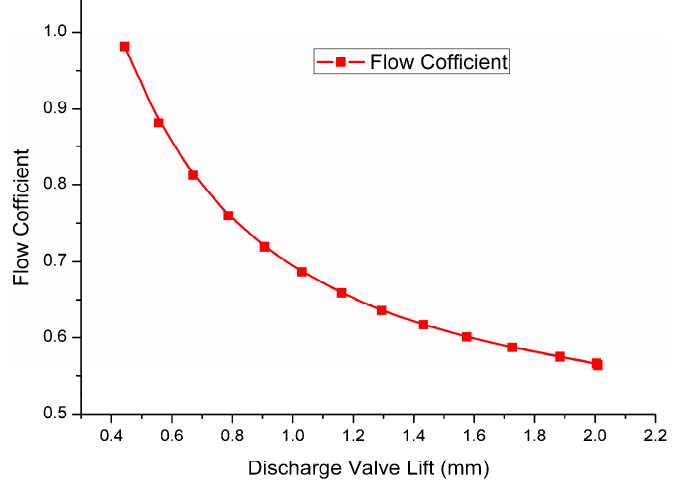
Figure 3. Flow coefficient of suction valve calculated by the FSI model.